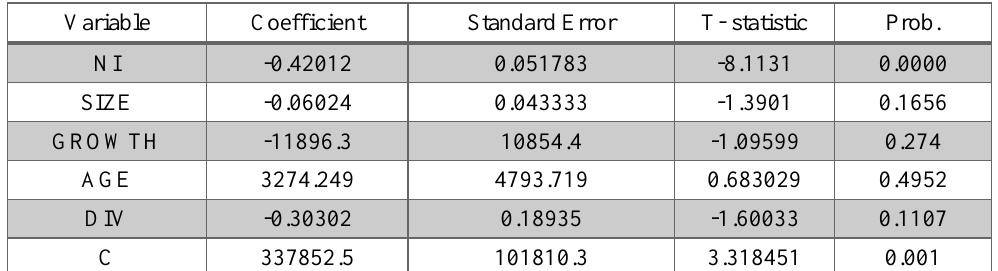
Table 5. Results of fixed effects- Model Number 2